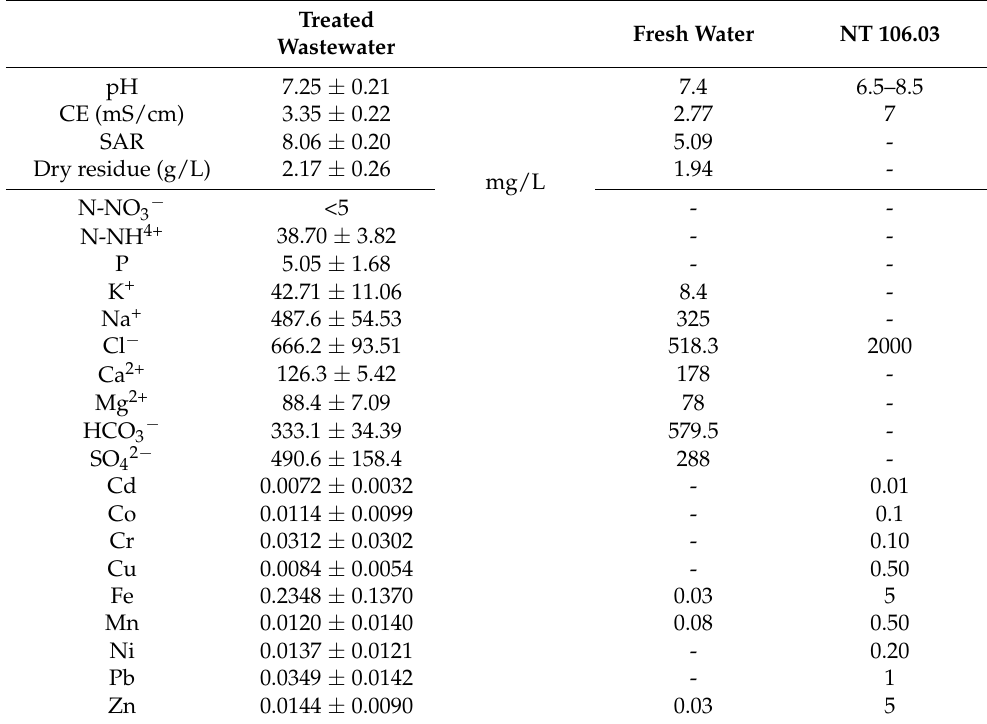
Table 3. Chemical properties of TWW and